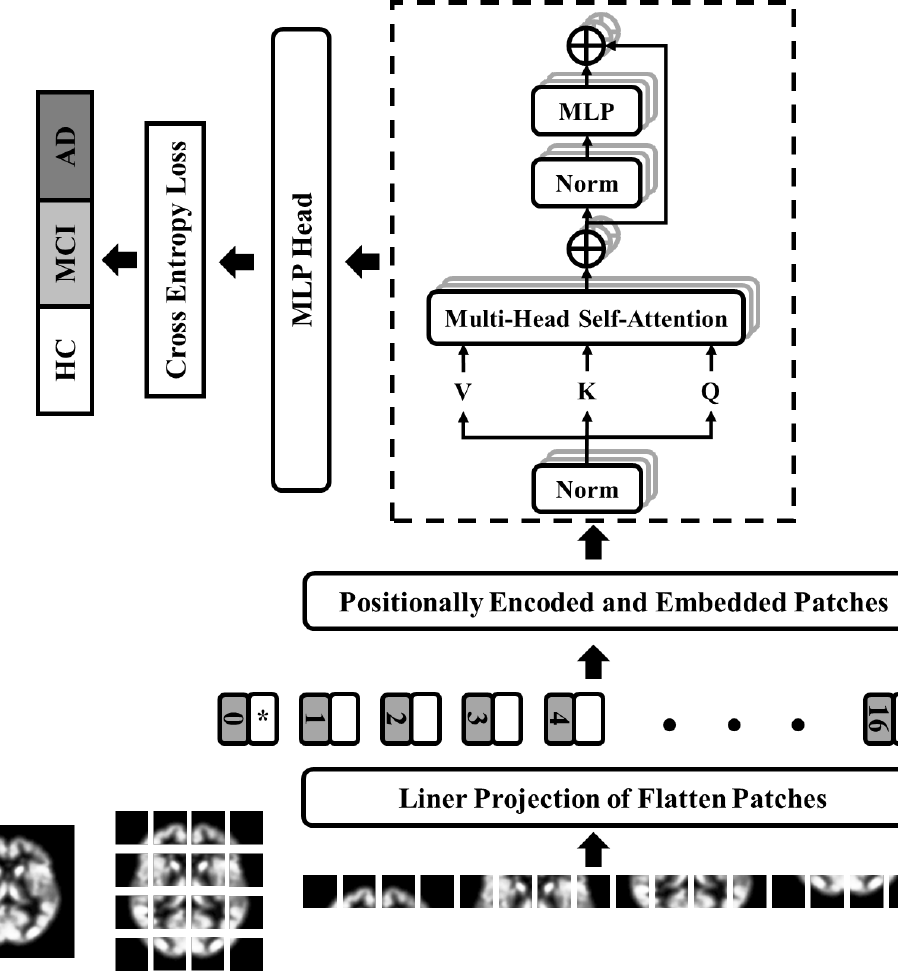
Figure 1. The OViTAD architecture is an optimized ViT shown for structural MRI data composed of a linear projection layer applied to the flattened patches fed into an 8-HSA Transformer. The MLP layer of 2048 parameters translates the features from the transformer encoder to a proper format for the cross-entropy loss